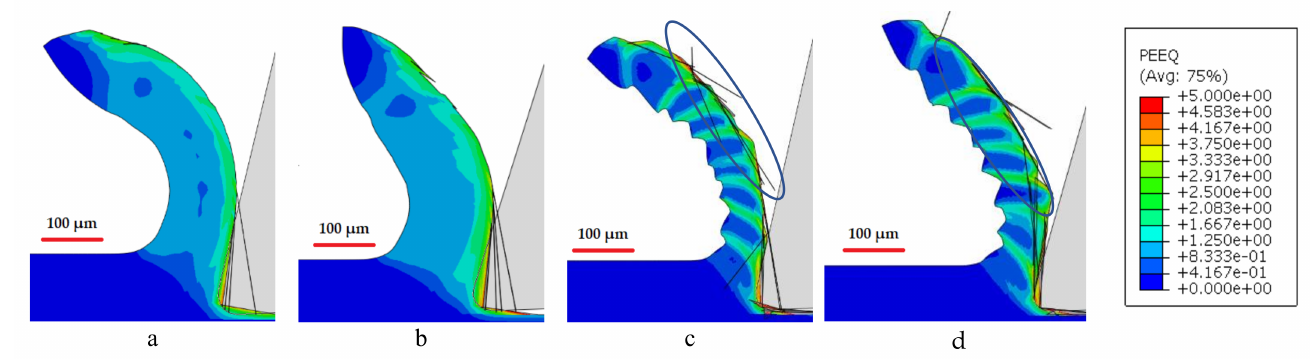
Figure 7. PEEQ contour ( a ) JC_1, ( b ) JC_Hou_2, ( c ) JC-Calalamz_3 and ( d ) JC-MTANH_3 for h = 60 µ m at 850 µ s of cutting